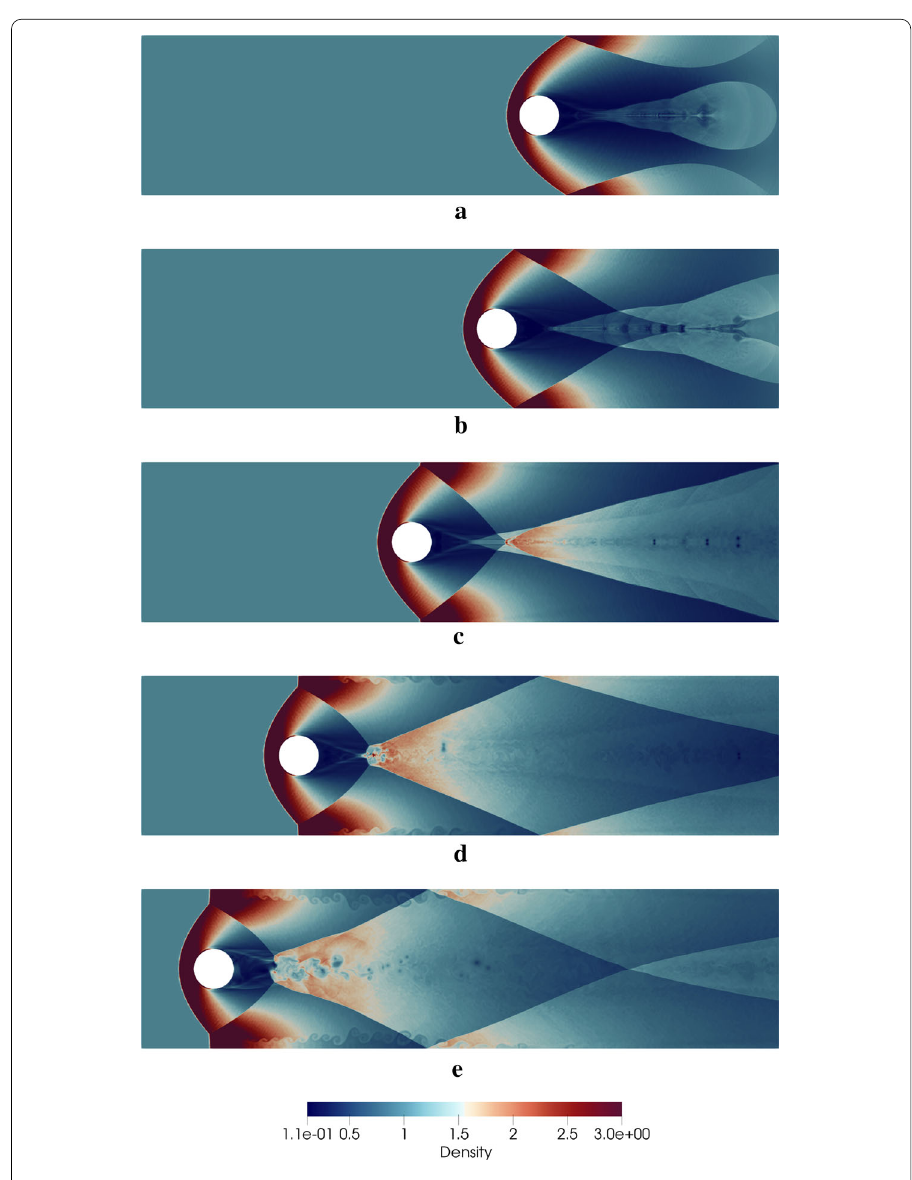
Fig. 14 Cylindrical geometry moves from an initial location near the outflow towards the inflow with a relative Ma = 3.0. The movement is captured showing the density after a 0.35 s, b 0.5 s, c 0.8 s, d 1.2 s and e